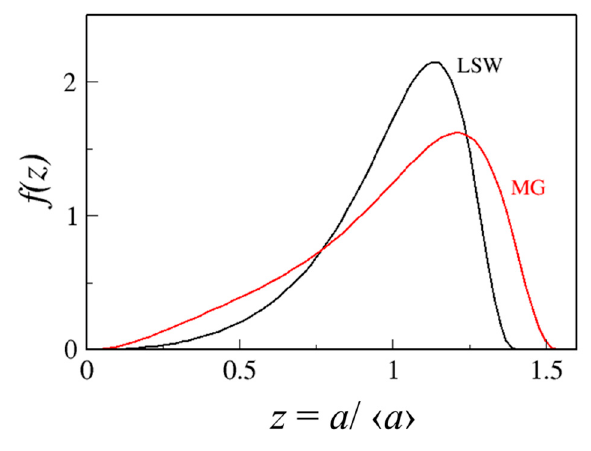
Figure 1. Stationary crystal size distribution for volume fraction φ = 0 (LSW) and for φ = 0.6 (MG).